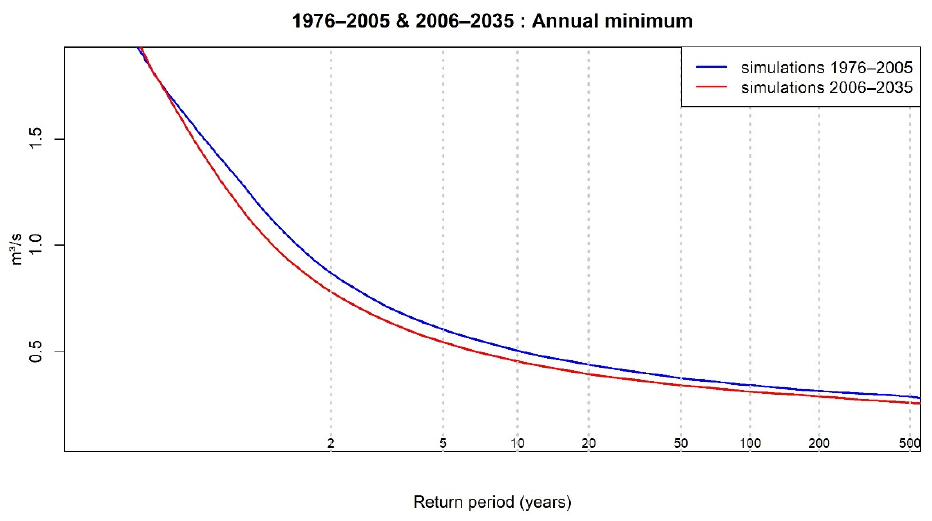
Figure 7. Annual minimum: sorted values of the 1000 simulations obtained with the whole frame- work (GCM+CDFt+HMM+MORDOR): over period 1976–2005 (blue curves) and period 2006–2035 (red curves).